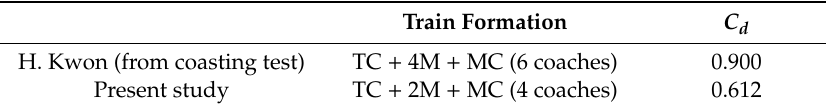
Table 3. Drag coe ffi cient of Table 3. Drag coefficient of HEMU-430X.